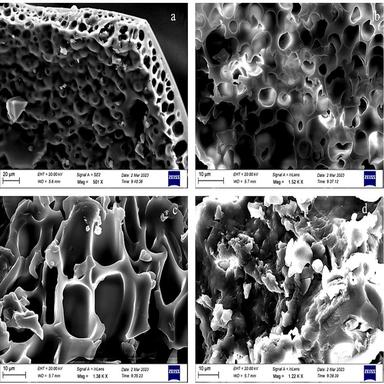
Scanning electron microscopic study of HPMC /copper nanobiocomposites.